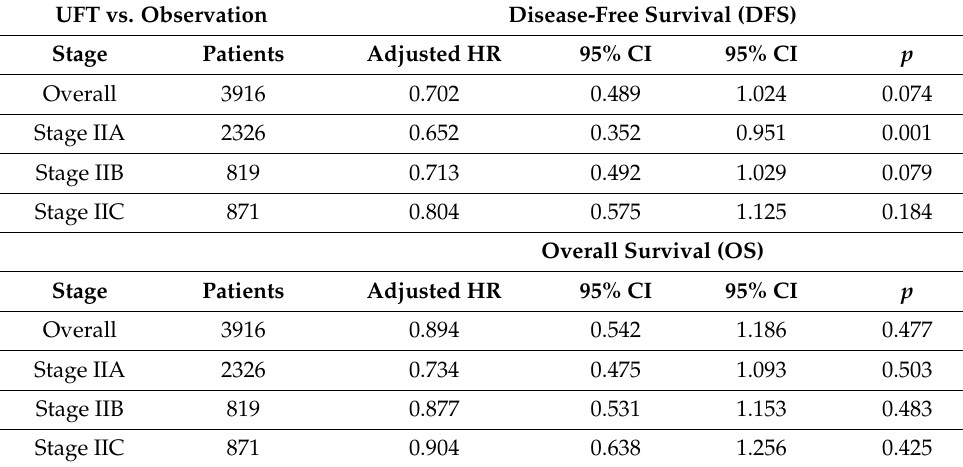
Table 3. Factors of prognosis stratified by cancer